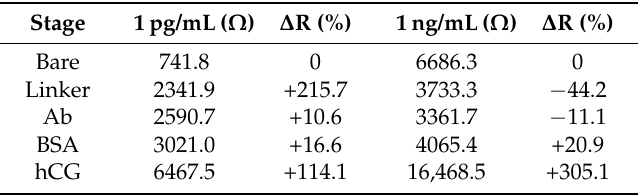
Figure 8. Characteristic I D –V D curves from the GFET sensors at different stages of biomolecule exposure for 1 pg/mL ( left ) and 1 ng/mL ( right ) hCG concentration levels. Table 1. Summary of GFET resistance changes measured at different stages of the functionalisation process with 1 pg/mL to 1 ng/mL concentration of hCG